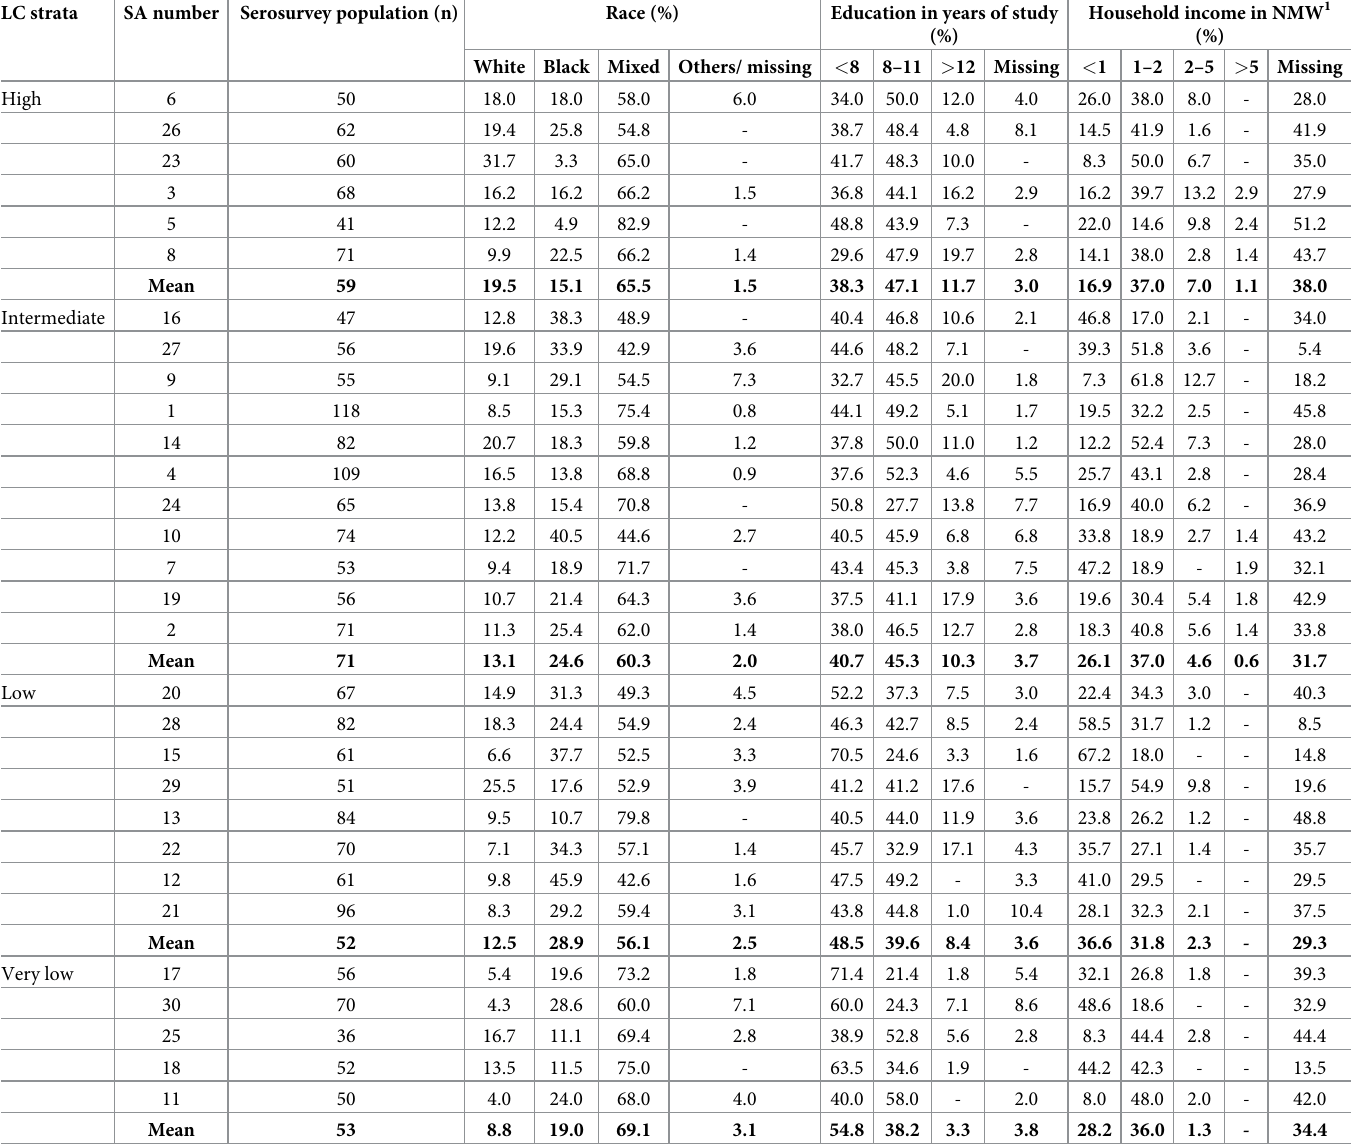
Table 1. Sociodemographic characteristics of the population of serological survey for chikungunya by Sentinel Area (SA) and Living Conditions (LC) strata. Feira de Santana–Bahia, April to September, 2017. LC strata SA number Serosurvey population (n) Race